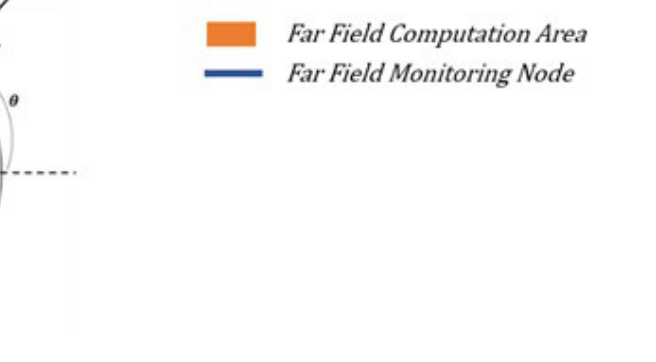
Figure 5. 2D Scattering model.